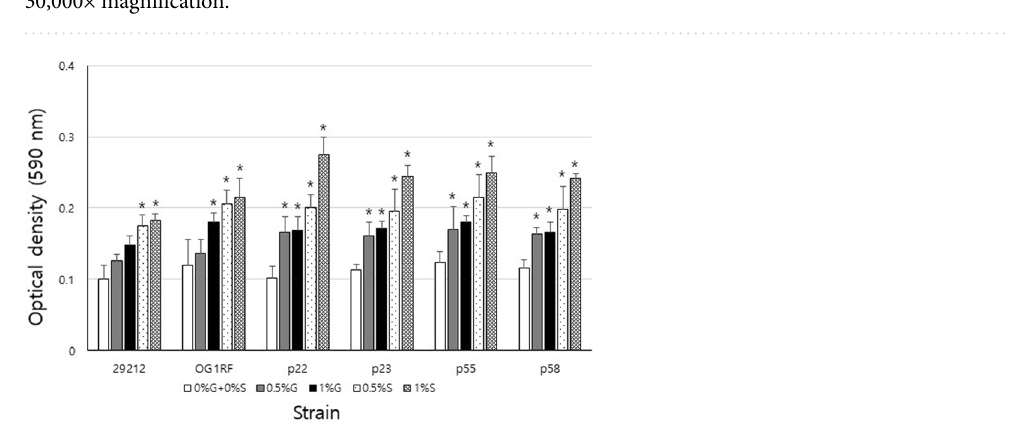
Figure 5. Biofilm formation of E. faecalis strains. Crystal violet staining was used to assay E. faecalis strain biofilm formation. The strains were cultured in 0% glucose + 0% sucrose (0%G + 0%S), 0.5% glucose (0.5%G), 1% glucose (1%G), 0.5% sucrose (0.5%S), or 1% sucrose (1%S). Data represent the mean and standard deviation of 3 independent experiments. Asterisks denote a statistically significant difference compared to 0%G + 0%S ( p <